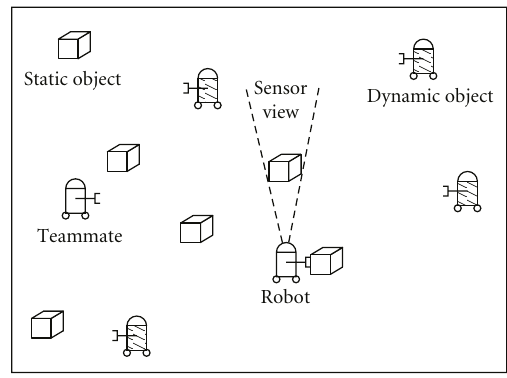
Figure 2: The general world modeling problem in a dynamic environment includes requiring a robot to use a narrow-scope sensor to track the positions of multiple (static and dynamic) objects in an environment. Determining when and how to use additional sources of information, such as from the e ff ects of actuation, and teammate sensor information is a nontrivial